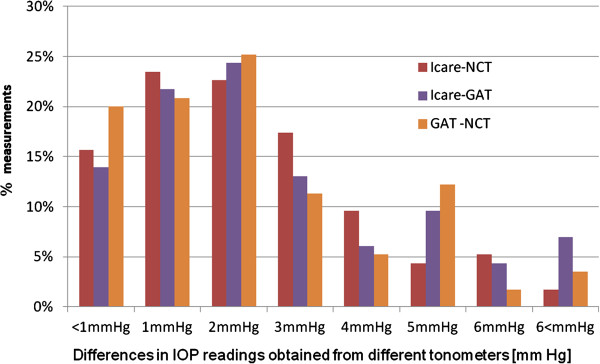
Percentage of measurements plotted against varying differences in IOP readings between the three instruments tested.